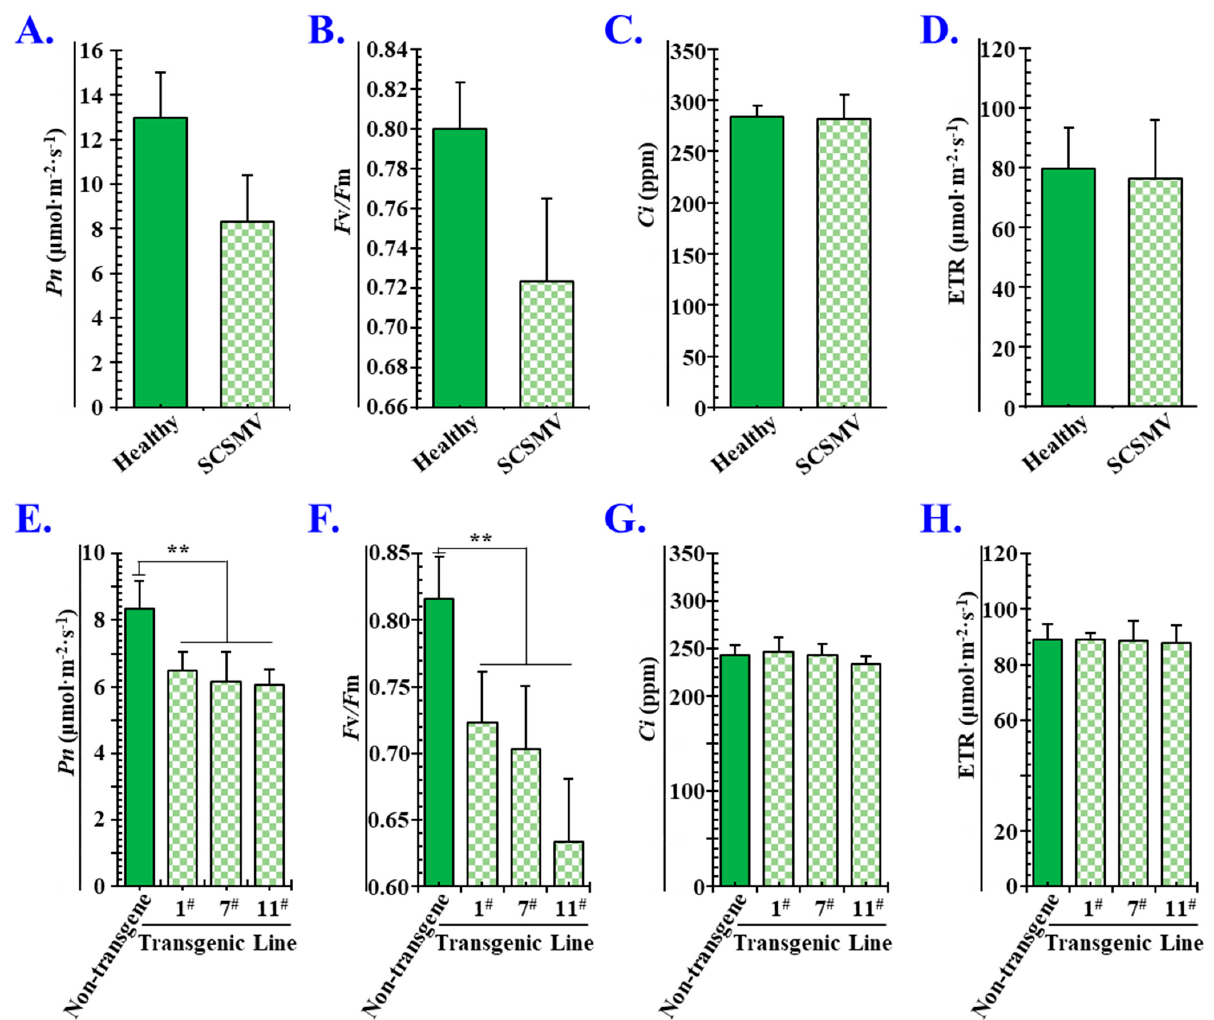
Figure 8. Effects of SCSMV infection and P1 SCSMV overexpression on photosynthesis. ( A ) Net photo- synthesis rate (Pn). ( B ) Maximal quantum yield (Fv/Fm). ( C ) Intercellular CO 2 mole fraction (Ci). ( D ) Electron transport rate (ETR) in SCSMV-infected sugarcane leaves. Each experiment was per- formed three times, and each treatment had at least three biological replicates. ( E – H ) Photosynthesis parameters Pn, Fv/Fm, Ci, and ETR in P1 SCSMV transgenic N. benthamiana , respectively. Error bars represent the standard error of the mean (SEM). Significant differences are indicated using a Student’s t -test: ** p -value < 0.01. # means different transgenic